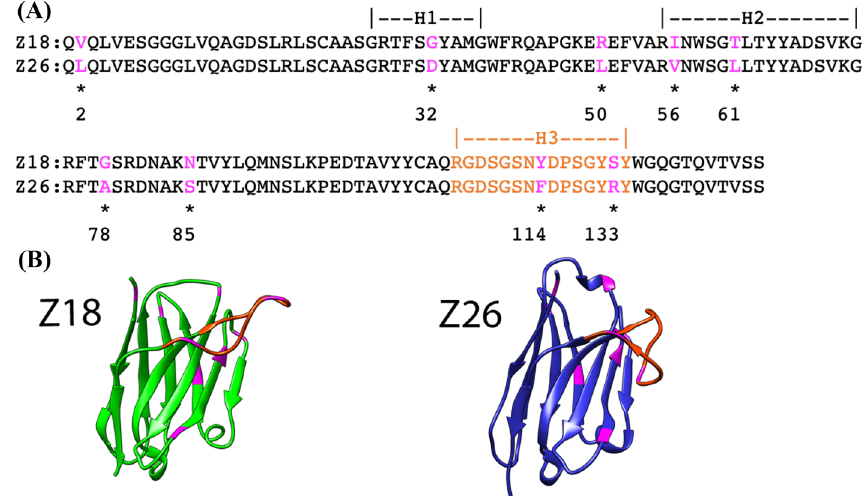
Figure 1. Comparison of amino acid sequences and predicted structures of the single-domain V H H antibodies Z18 and Z26. ( A ) Amino acid sequences of Z18 and Z26. CDR regions are indicated and amino acids that are not identical are indicated by asterisks. Residues are numbered according to the IMGT numbering scheme 39 . ( B ) Homology models of Z18 and Z26. The CDR-H3 and mutational positions are shown in orange and magenta, respectively. Protein images were generated with UCSF Chimera 40